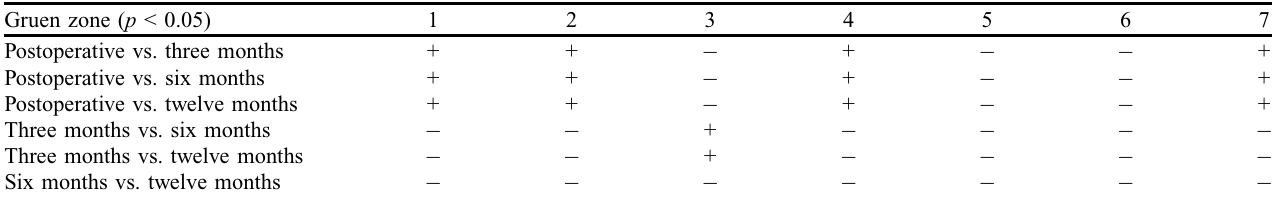
Table 4. Comparison between postoperative DEXAvalues and those at three, six, and twelve months and comparing values at three, six, and twelve months with each other.